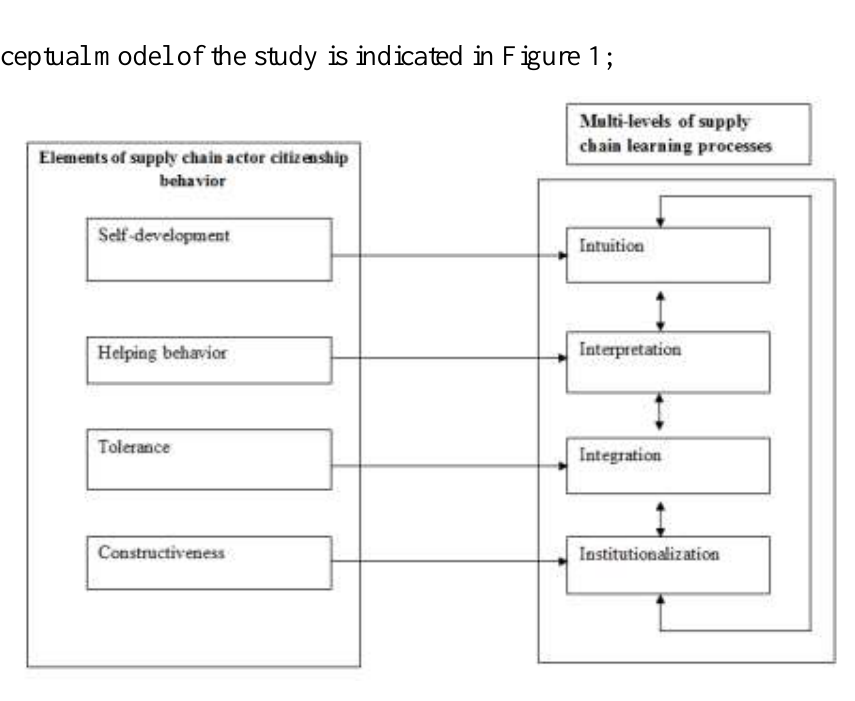
Figure 1: Conceptual model of the